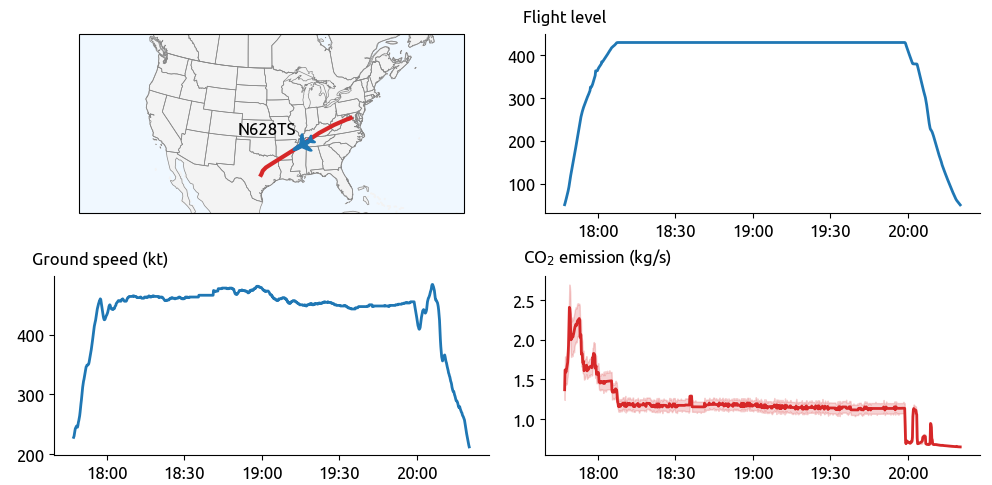
Figure 3. An example GLF6 flight and estimated CO 2 emissions.